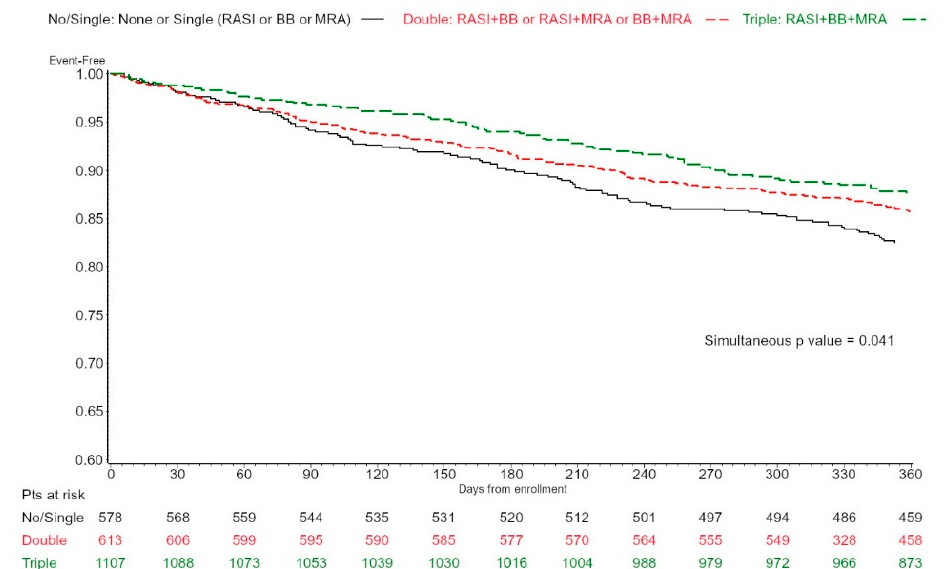
Figure 1. Age-adjusted Kaplan–Meier curves on all-cause mortality or cardiovascular hospitalization according to conventional NHM (RASI, betablockers, and MRA), none/single vs. double vs. triple, in 2298 patients with HFmrEF after adjustment by age categories. NHM, neurohumoral modulation.